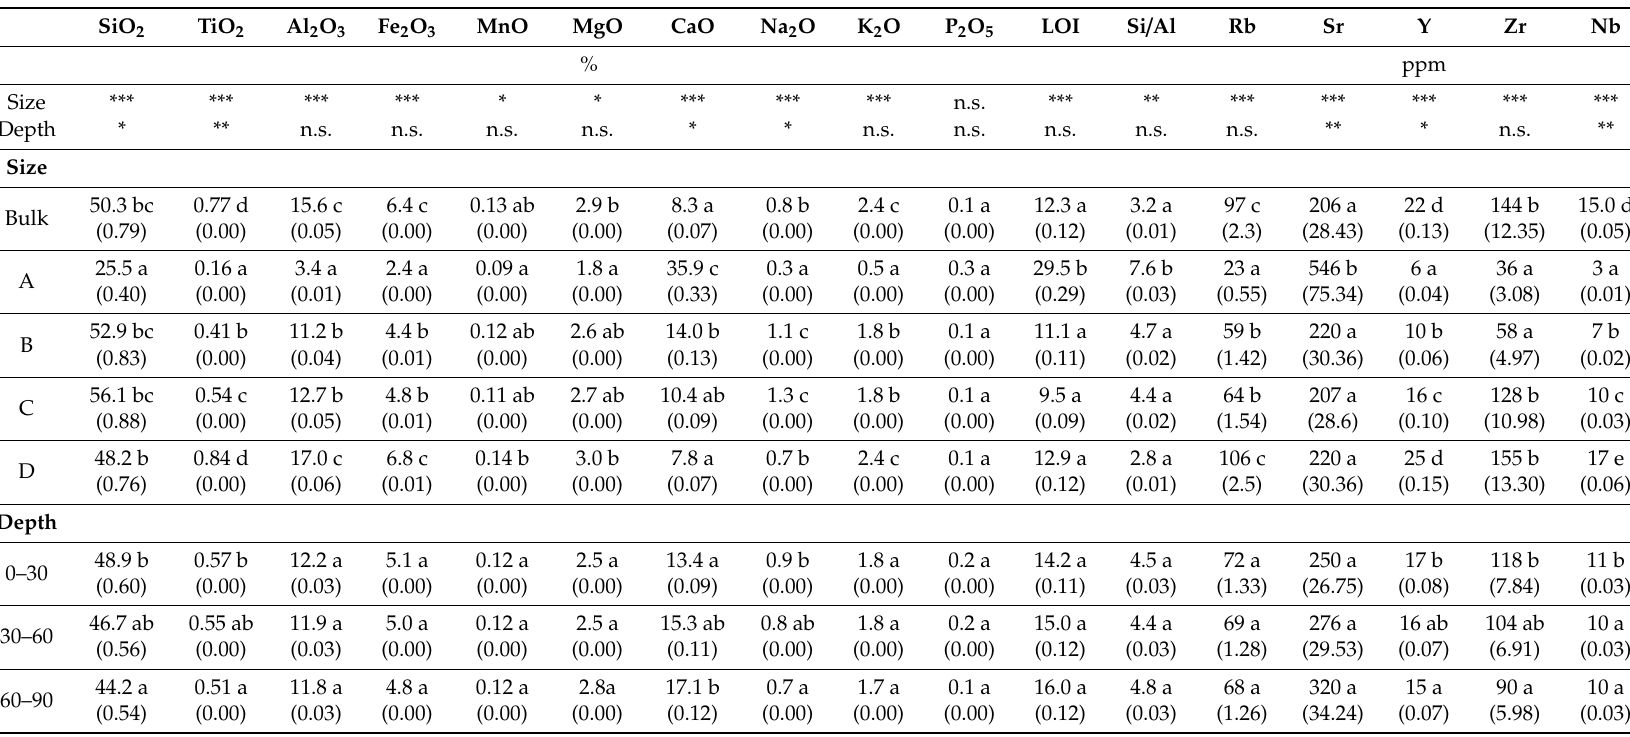
Table 1. Analysis of variance and mean values of the major elements (wt %) and some trace elements (ppm) subdivided by soil depth and size fractions under NT